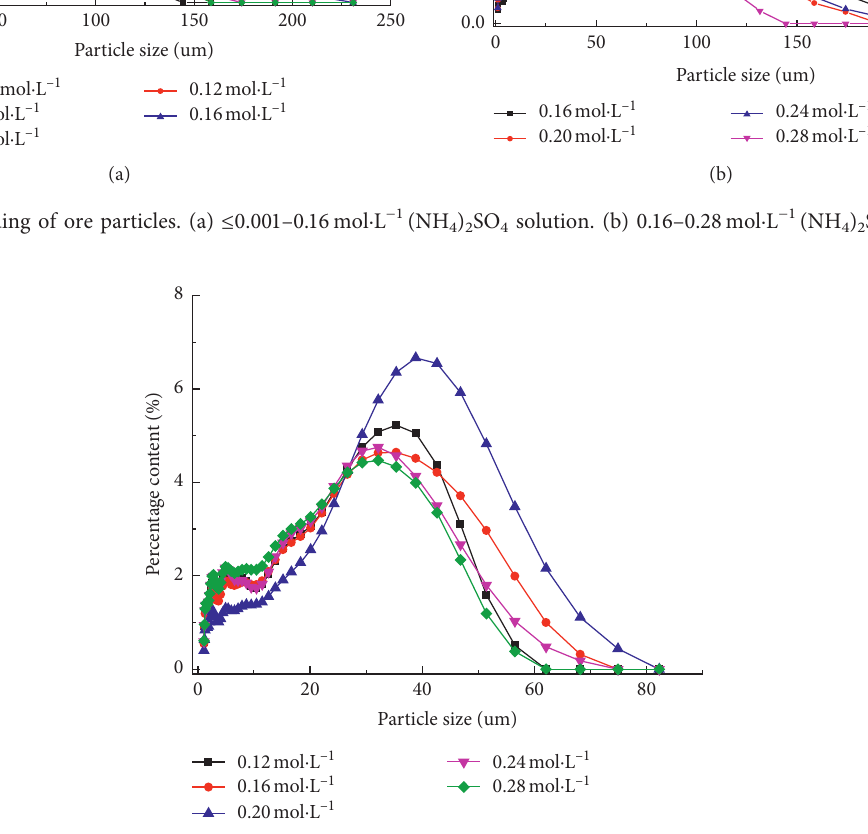
Figure 9: Grading of ore particles smaller than